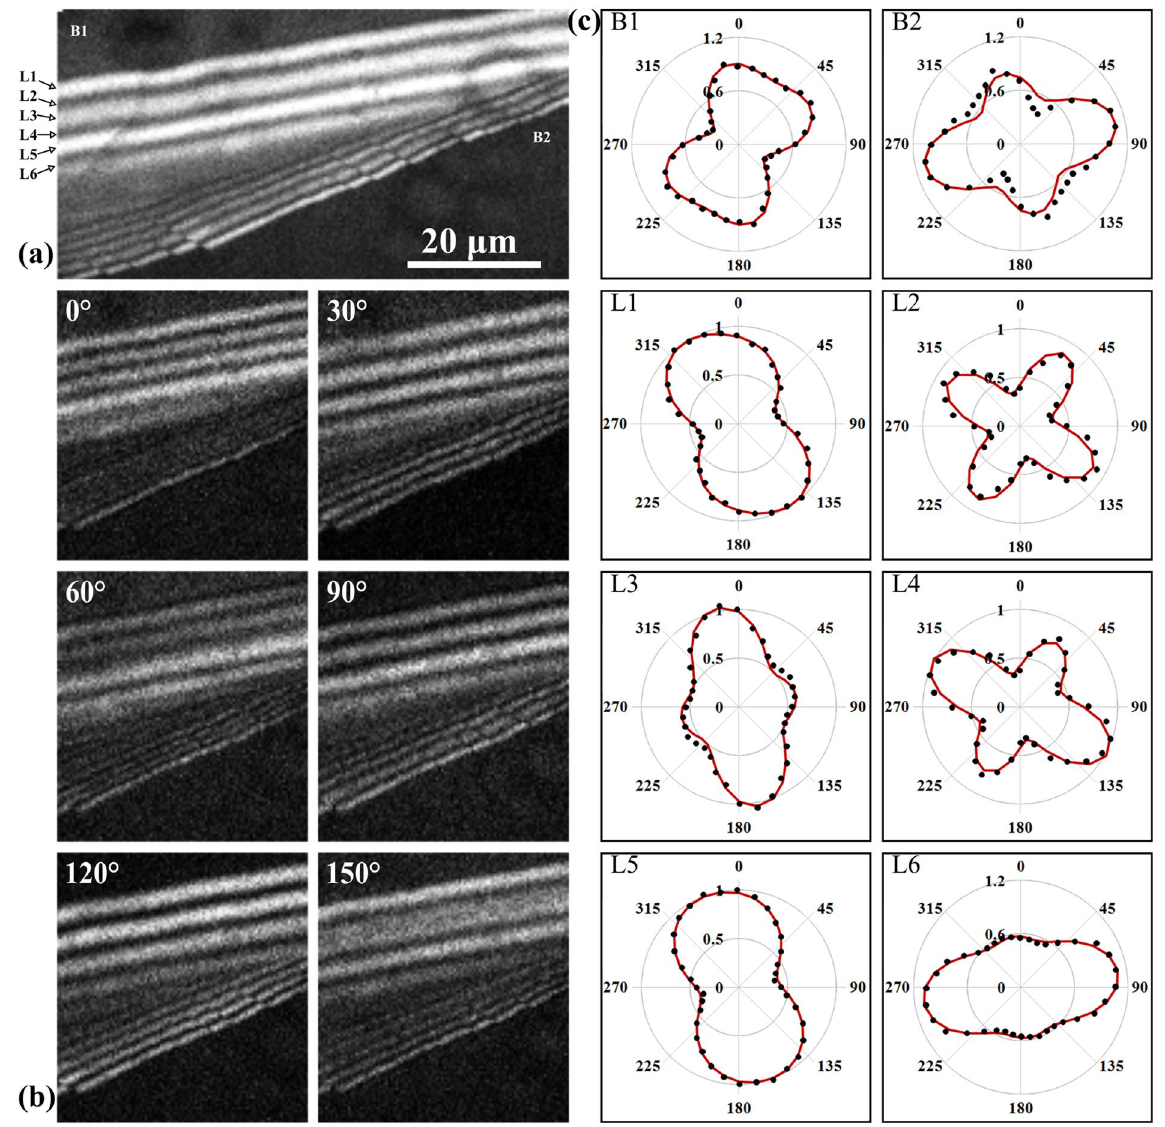
Figure 2. SHG intensity dependence on the laser beam polarization for a 4H-SiC epilayer containing SFs. ( a ) Polarization-independent SHG image obtained as the sum of all the images acquired with tunable linear laser beam polarization. The eight considered ROIs coded L1 to L6, B1 and B2 are illustrated. ( b ) PSHG images for six different linear laser beam polarizations. ( c ) The average SHG intensity as a function of the incident polarization angle α (varied from 0° to 360° in steps of 10°) for the two regions surrounding the defected area (B1 and B2) and the six alternating high and low SHG intensity lines (L1–L6) marked in ( a ). The black dots in the polar plots correspond to the experimental data points while the solid line is the fitting with the theoretical curve, either Eqs 1, 2 or a linear combination of the